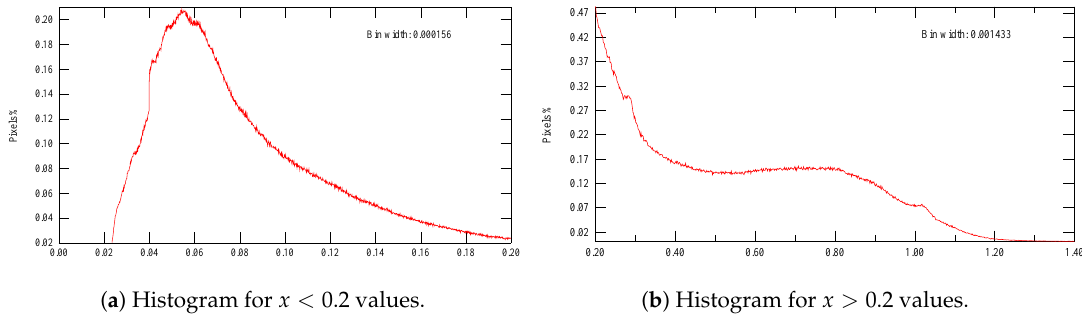
Figure 9. Histograms of the two x -value groups (Equation (10)) of MODIS data to define the ANNs’ inputs.